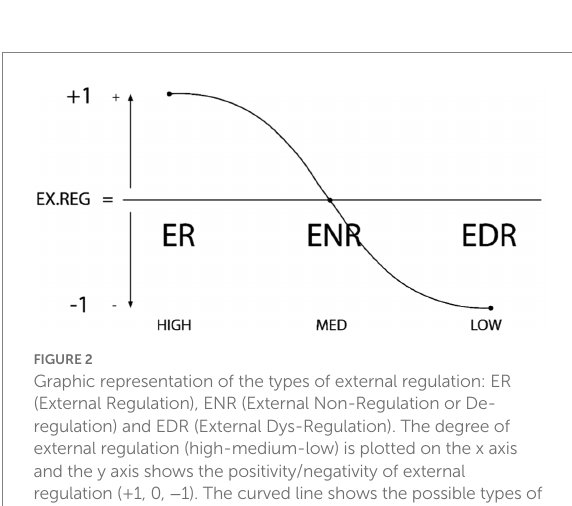
FIGURE 2 Graphic representation of the types of external regulation: ER (External Regulation), ENR (External Non-Regulation or De- regulation) and EDR (External Dys-Regulation). The degree of external regulation (high-medium-low) is plotted on the x axis and the y axis shows the positivity/negativity of external regulation (+1, 0, − 1). The curved line shows the possible types of the context regulatory types and the possible directionality of the change in types of